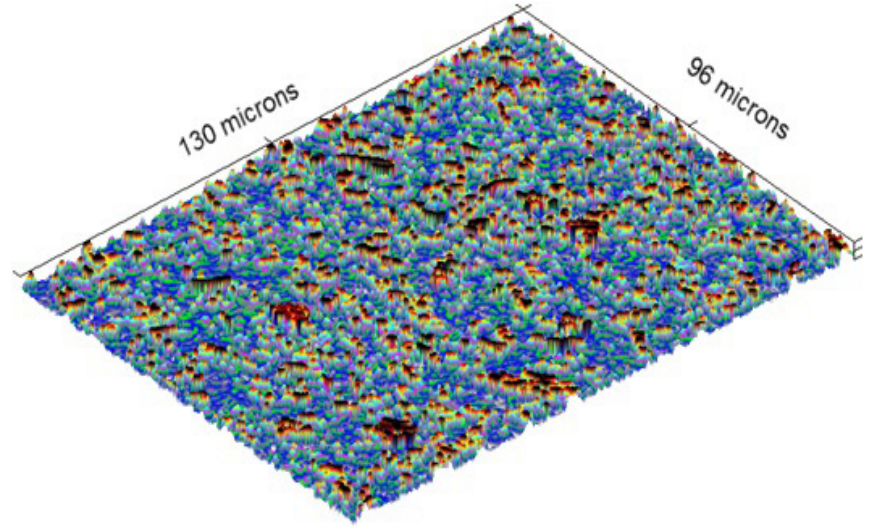
Figure 7. AFM image of Nitinol composite at sintering temperature 1000 0 C for 5 minutes.